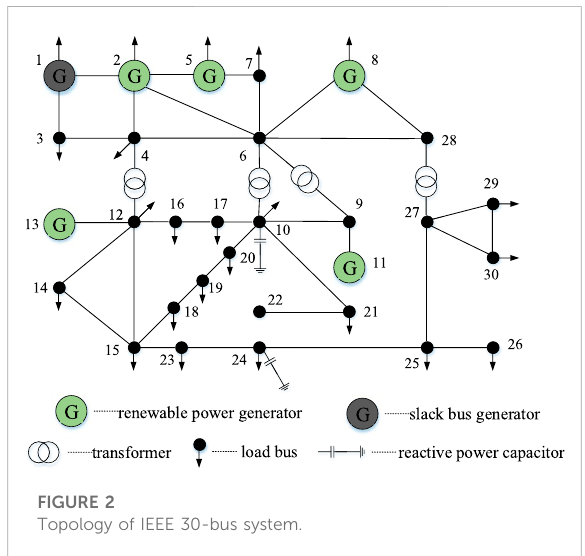
FIGURE 2 Topology of IEEE 30-bus